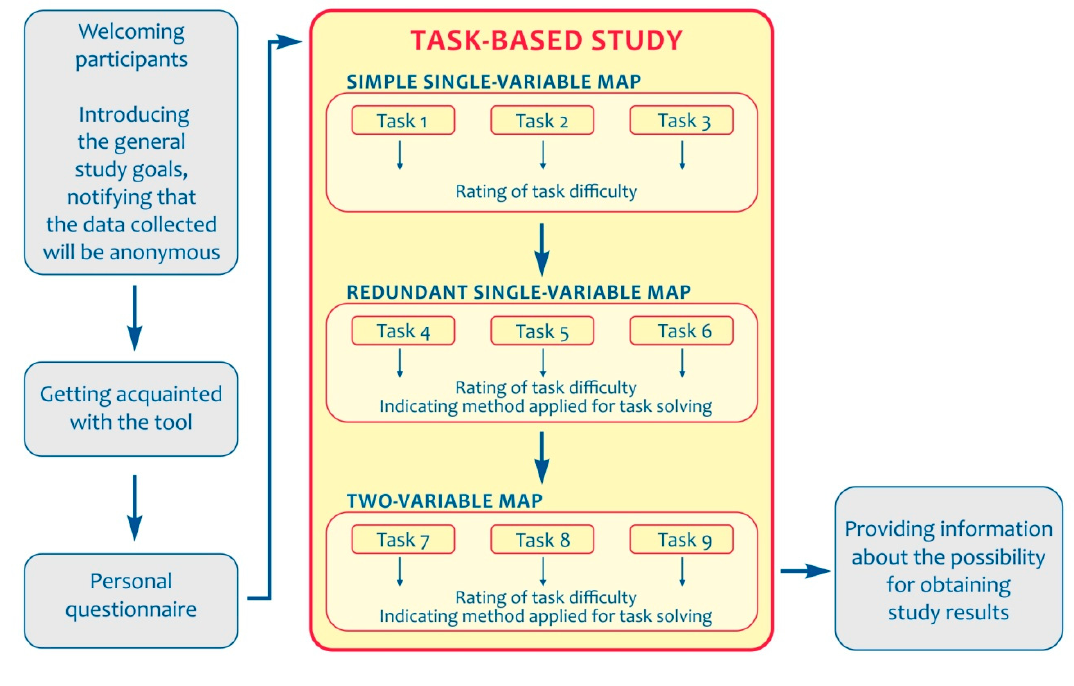
Figure 4. Study procedure.